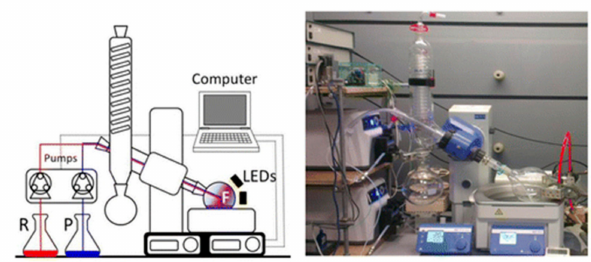
Figure 3. Image of the photochemical reactor set up (reproduced with permission from